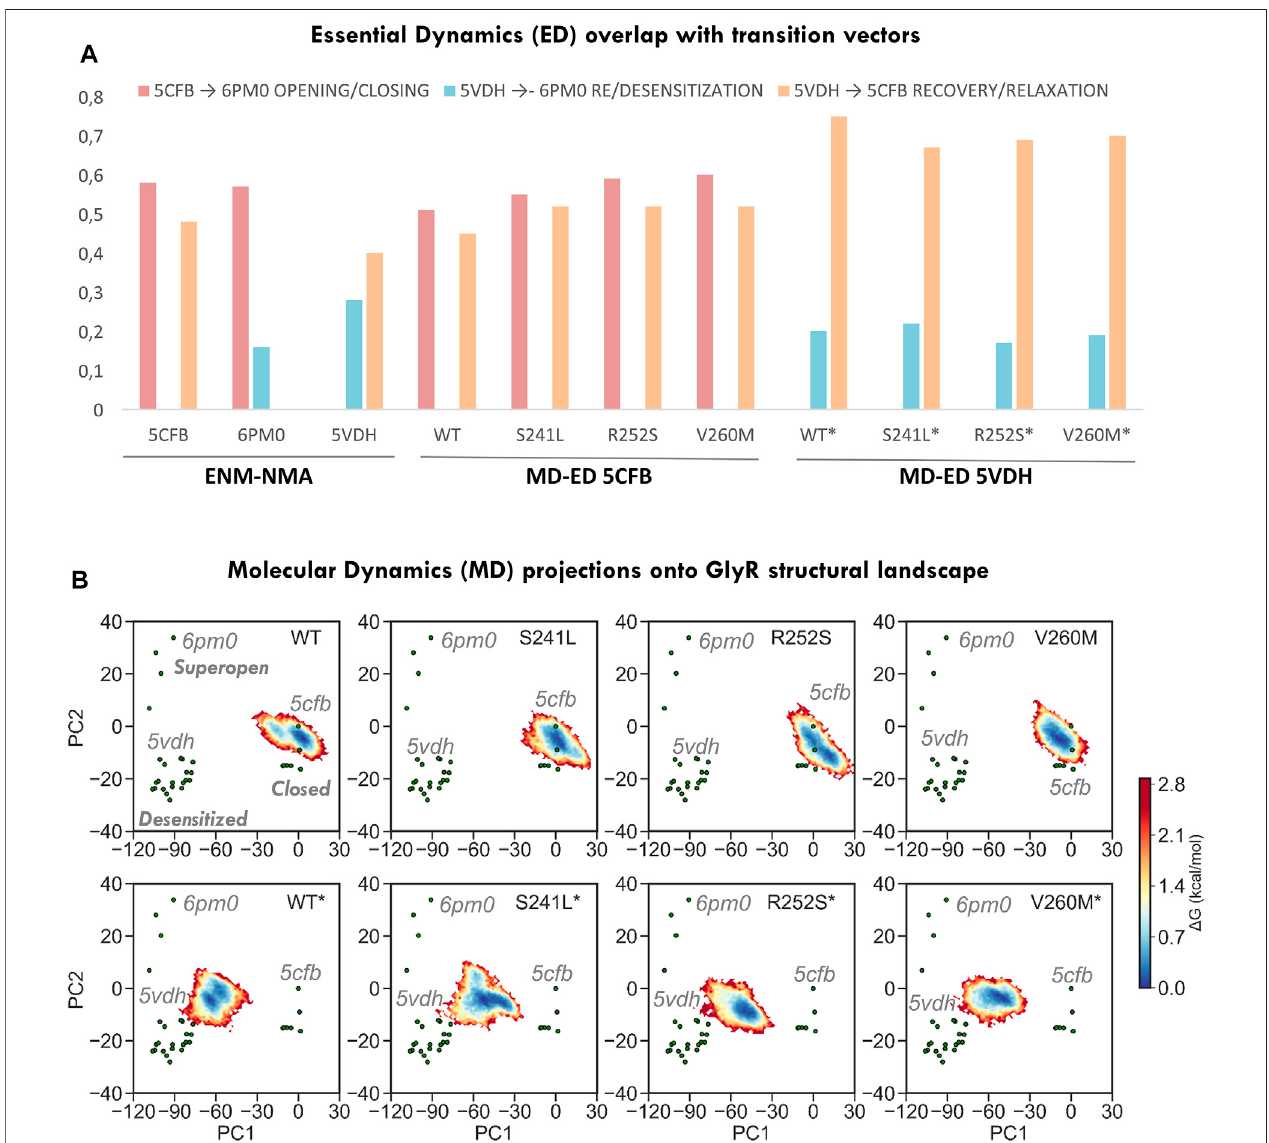
FIGURE3 | Conformational space sampling byelasticnetworkmodels and essential dynamicsacross thethree major axis for transition de fi ned byclosed (5CFB), desensitized (5VDH), and super-open (6PM0) structures from each PC cluster. (A) Overlap between the fi rst 10 ENM modes computed from the three state representativesversusthethreetransitions(left)andbetweenthe fi rst10EDmodesfrom5CFBand5VDHsimulationsversusthethreetransitions(right). (B) Relativefree energy landscapes for 1.2 us meta-trajectories upon projection onto PC1-2. Note how simulations from 5CFB (top row) extend in the direction of super-open structures, and while for WT GlyR populate two minima, for mutations sample an elongated one. On the contrary, simulations from 5VDH evolve toward the closed cluster, while for WT GlyR they point to 5cfb, mutants tend to evolve to collapsed closed states that project at negative PC2 values. All simulations from 5VDH are indicated with